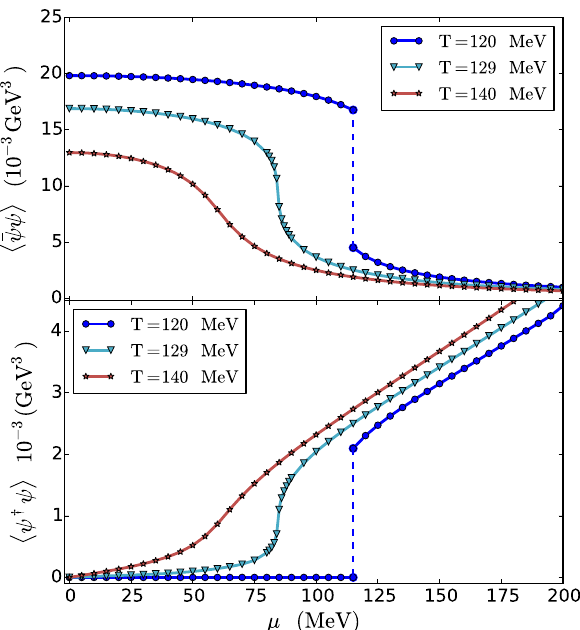
Fig. 1 The quark condensate and quark number density varying with μ at T = 110 MeV, T = 120 MeV, T = 129 MeV and T = 140 MeV, respectively